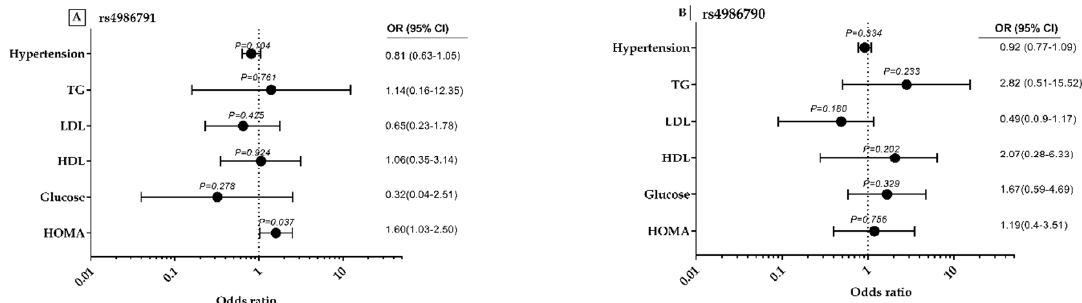
Figure 5. The genetic variants rs4986791 (Thr399Ile) and rs4986790 (Asp299Gly) polymorphisms